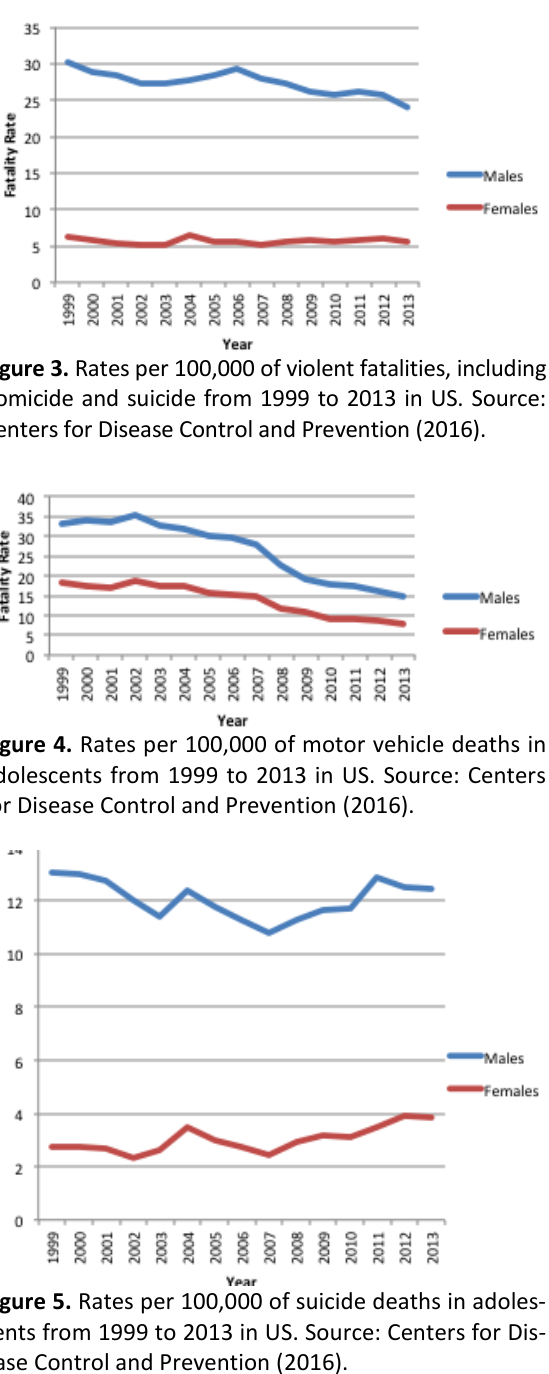
Figure 2. Birth rates to adolescents ages 15–19 in US from 1990–2013. Source: Office of Adolescent Health (2016).